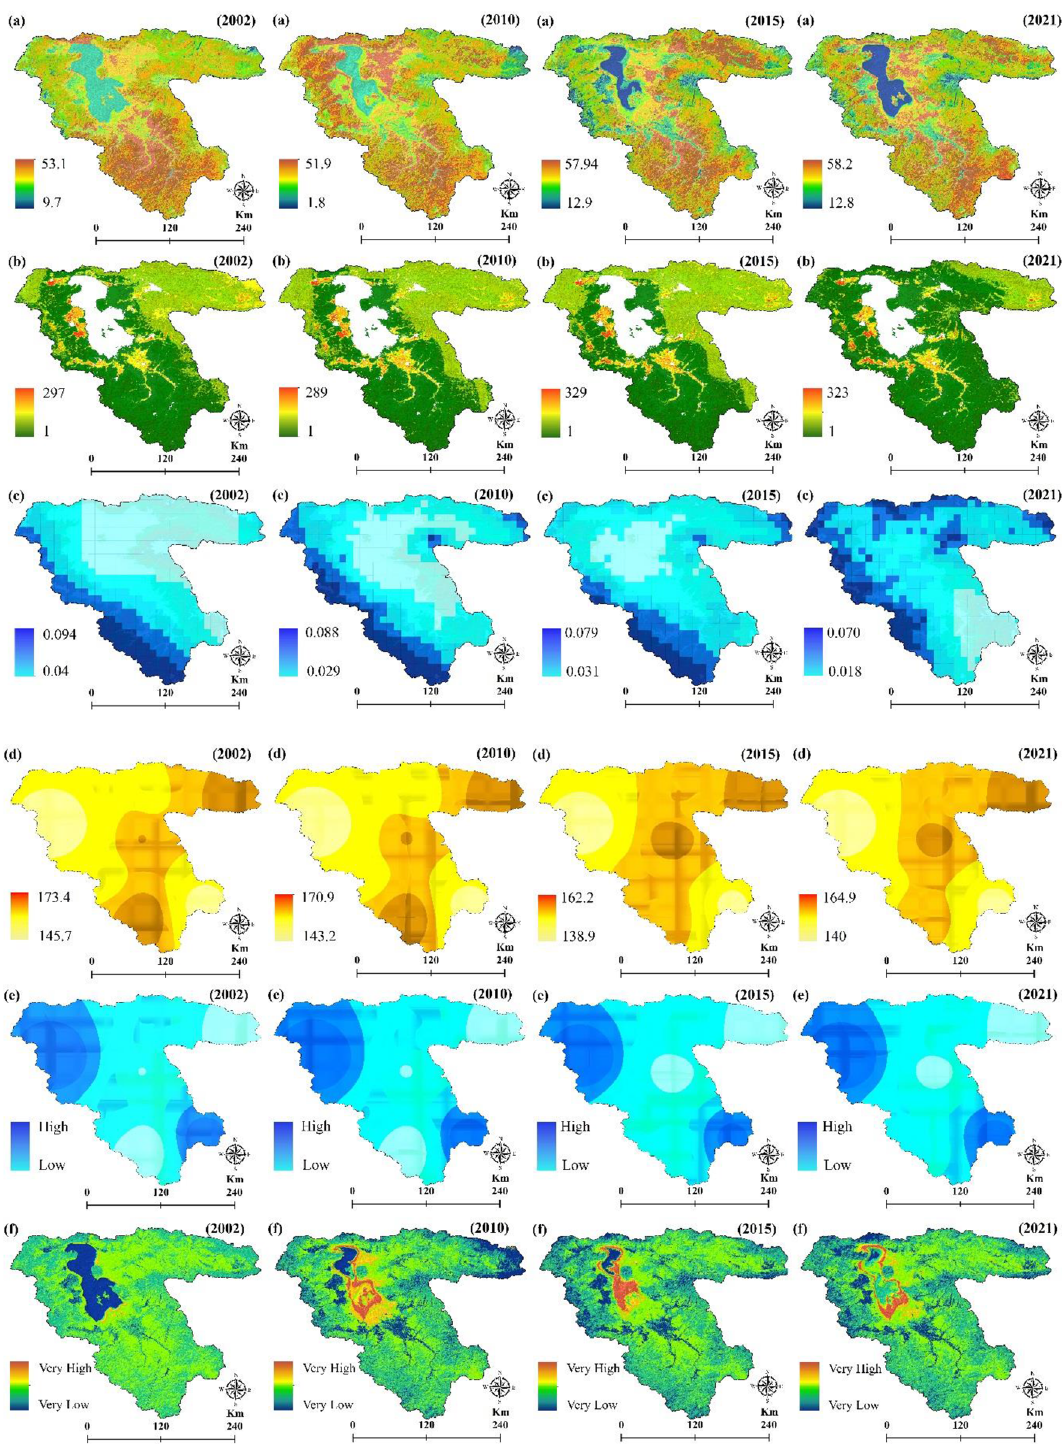
Figure 1. Predisposing variables for assessing the impacts of climate change on the FS, generated in the ArcGIS 10.6 software (www. esri. com); ( a ) LST (°C) for years 2002, 2010, 2015, and 2021, ( b ) ET in milliliter for years 2002, 2010, 2015, and 2021, ( c ) precipitation for years 2002, 2010, 2015, and 2021, ( d ) sunny days for years 2002, 2010, 2015, and 2021, ( e ) cloud ratio in percentage for years 2002, 2010, 2015, and 2021, ( f ) soil salinity distribution for years 2002, 2010, 2015, and 2021, ( g ) soil moisture for years 2002, 2010, 2015, and 2021, ( h ) groundwater quality for years 2002, 2010, 2015, and 2021, ( i ) soil types, ( j ) DEM, ( k ) slope in degree, and ( l )